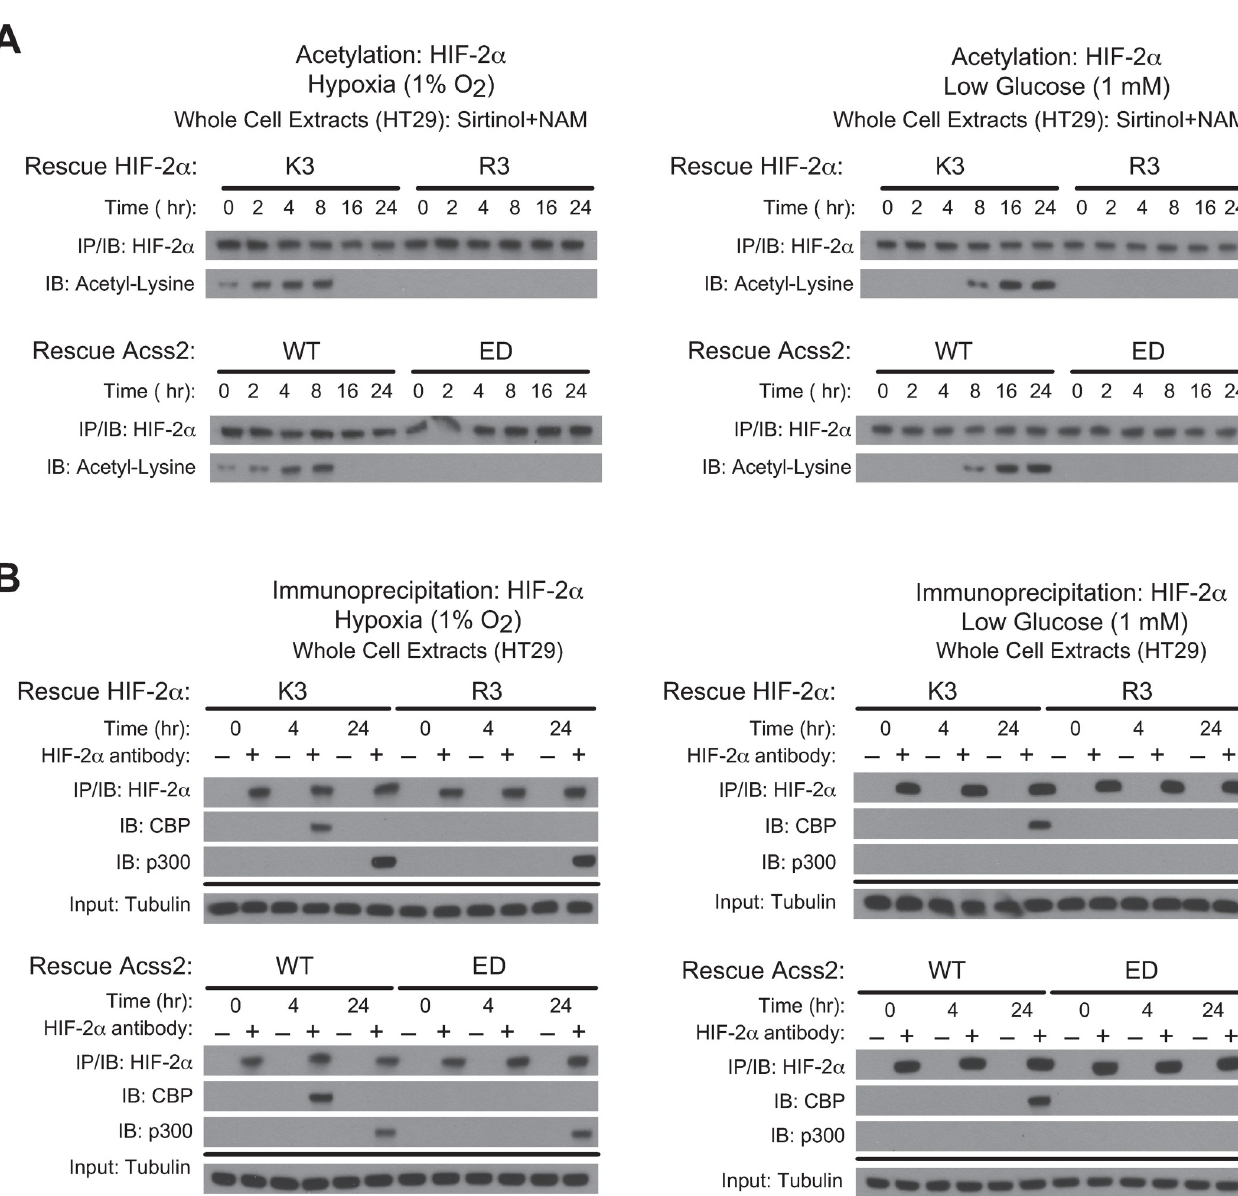
stress conditions or following acetate supplementation. These mutations in HIF-2 α or Acss2 had no or minimal effect on these parameters under control conditions.